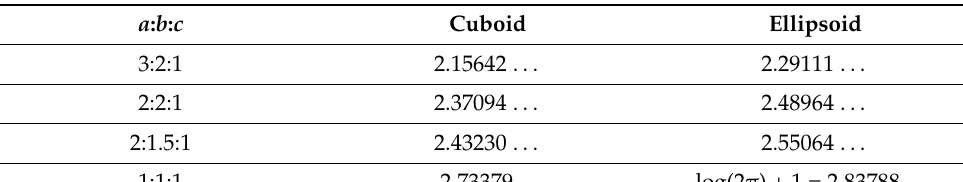
sphere. Table 4. The shape entropies of cuboids and ellipsoids. Table 4. The shape entropies of cuboids and ellipsoids.